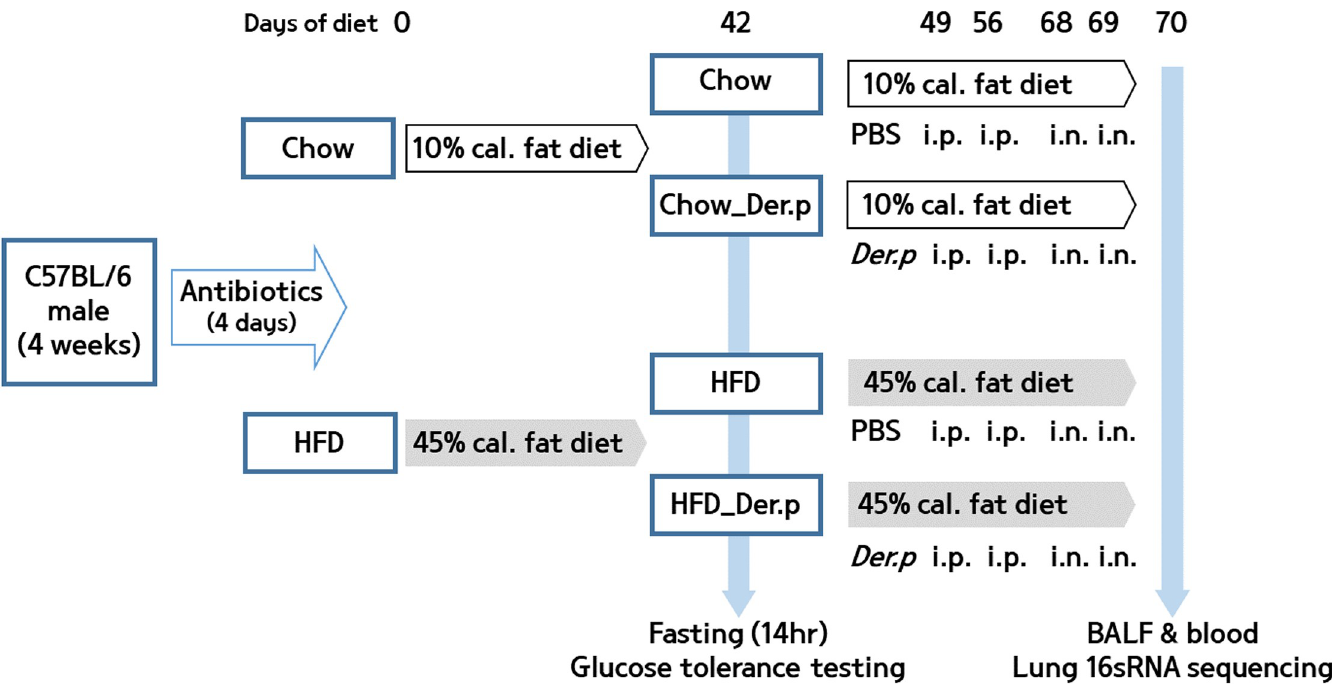
Fig 1. Overview of the experiment. From 4 weeks of age, C57BL/6 male mice (n = 33) were pretreated with a cocktail of antibiotics for 4 days, and separated into 2 treatment groups and fed either a normal diet (Chow, n = 16) or high fat diet (HFD, n = 17). A glucose tolerance test (GTT) was performed after mice had been fed either diet for 42 days. From 49 days, the two diet groups were separated into 2 groups respectively, a normal diet-fed group with phosphate-buffered saline (PBS) sensitization and challenge (Chow, n = 9), a normal diet-fed group with Der.p sensitization and challenge (Chow_Der.p, n = 7), a high fat diet-fed group with PBS sensitization and challenge (HFD, n = 7), and a high fat diet-fed group with Der.p sensitization and challenge (HFD_Der.p group, n = 10). After 70 days of diet, blood and lung tissues were collected.